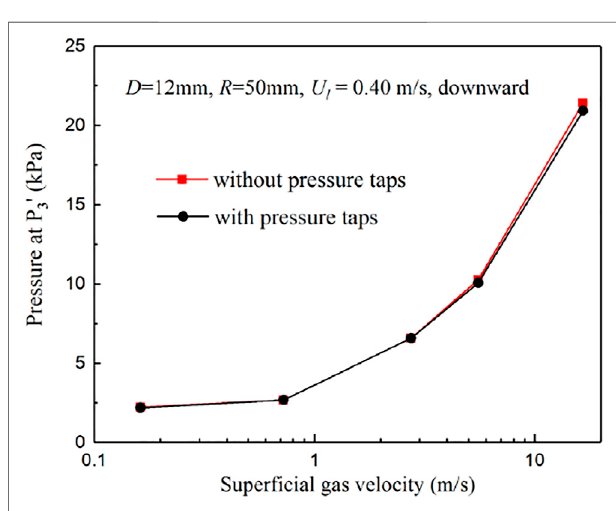
FIGURE4| Effectofthe1-mmpressuretapon fl uidpressureinthetube.